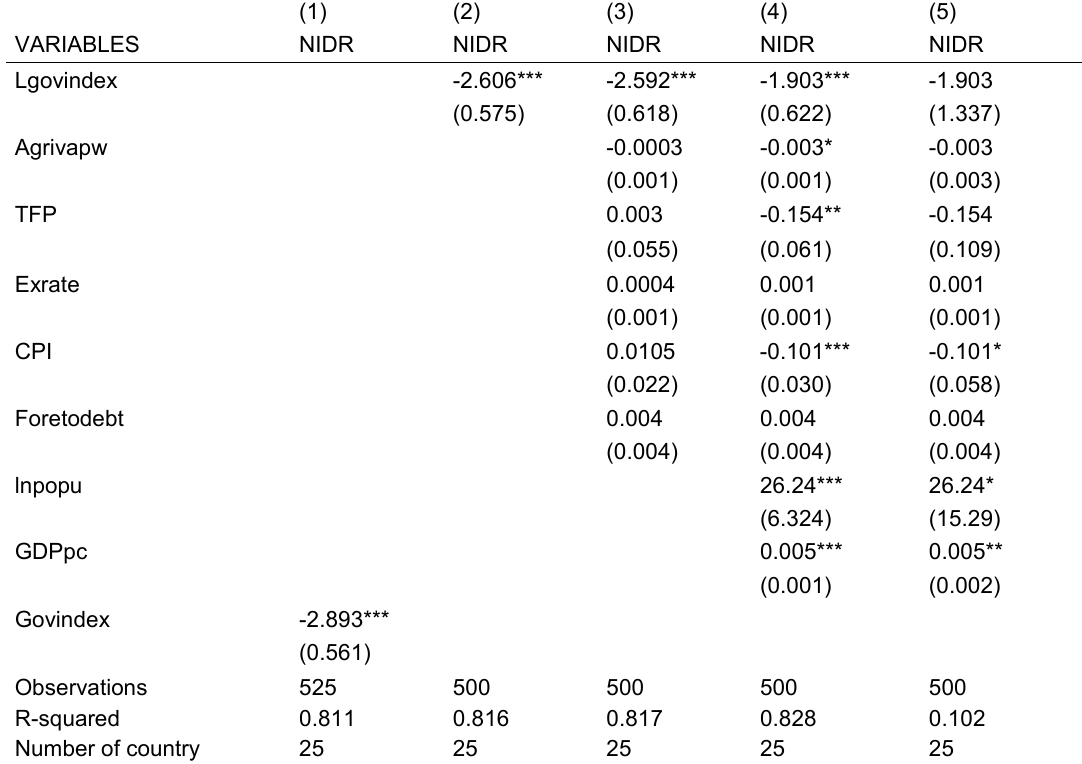
Table 4. Regression results for net-import dependency and the composite governance